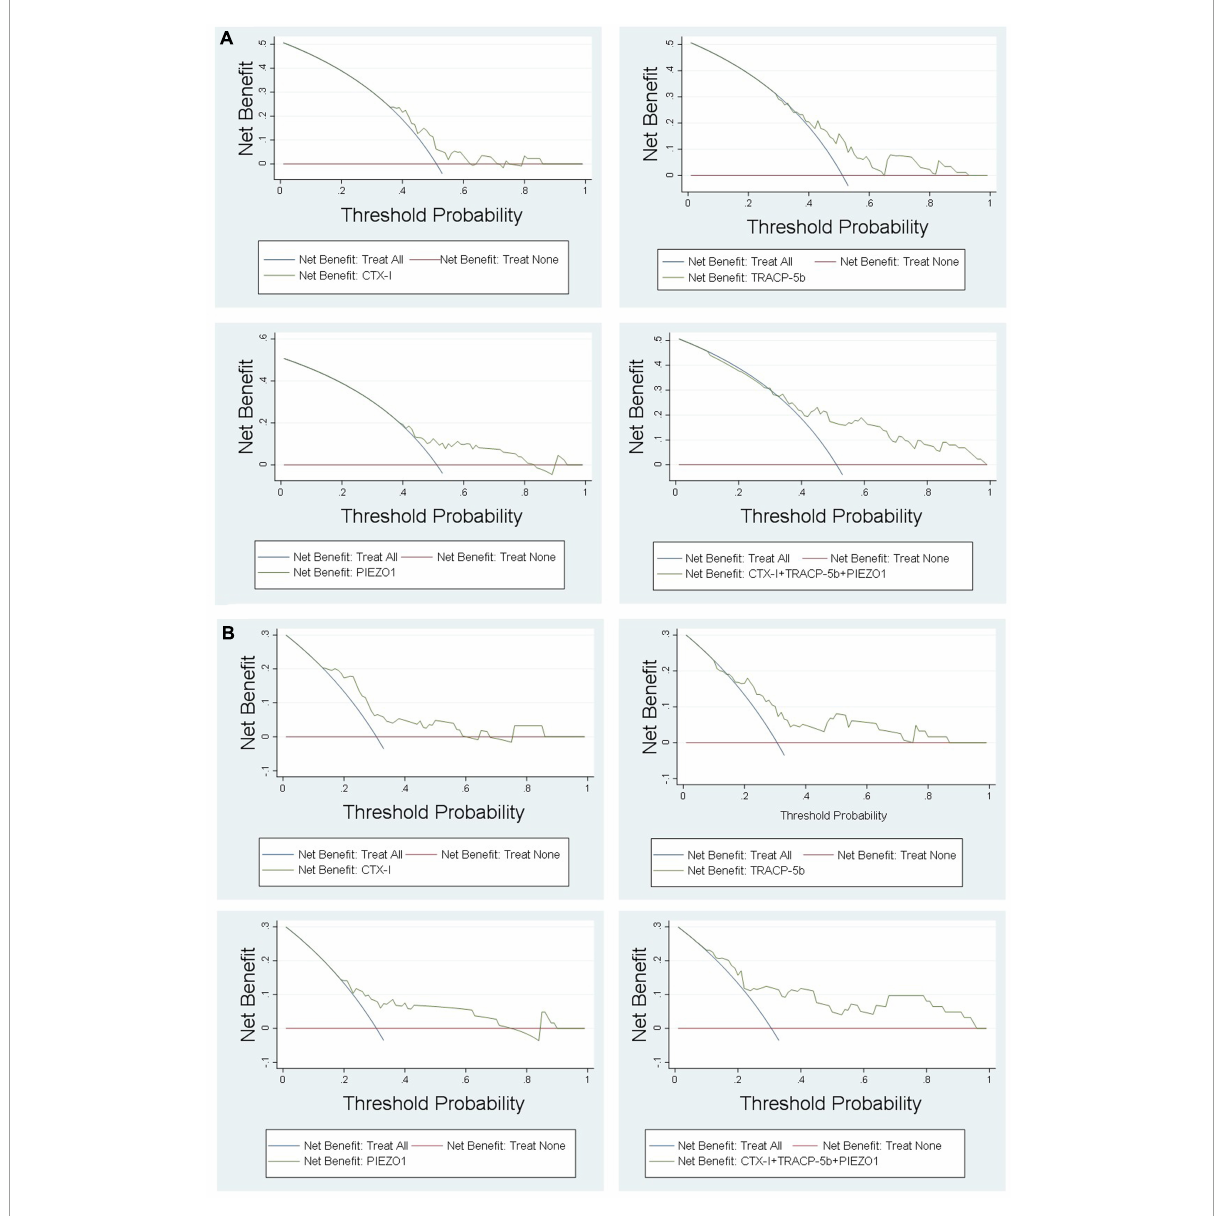
FIGURE4 DCA results. (A) Sepsis vs. non-sepsis; (B) sepsis shock vs.